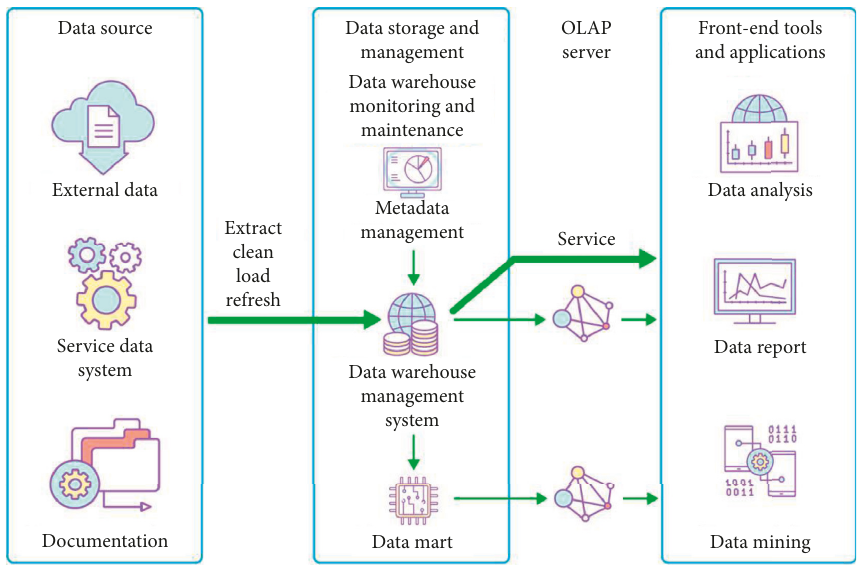
Figure 1: Intelligent warehouse data classification